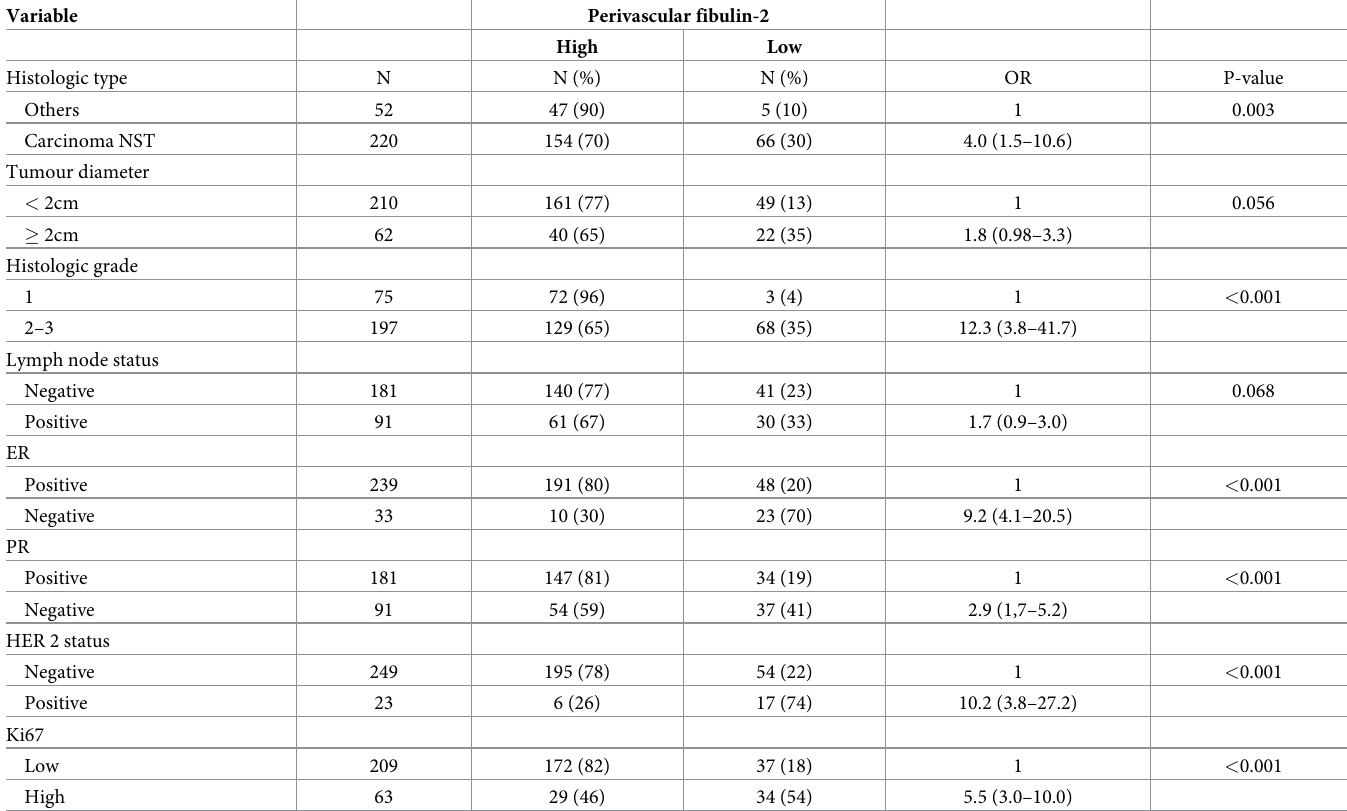
Table 1. Associations between perivascular fibulin-2 expression and clinico-pathological features (n =